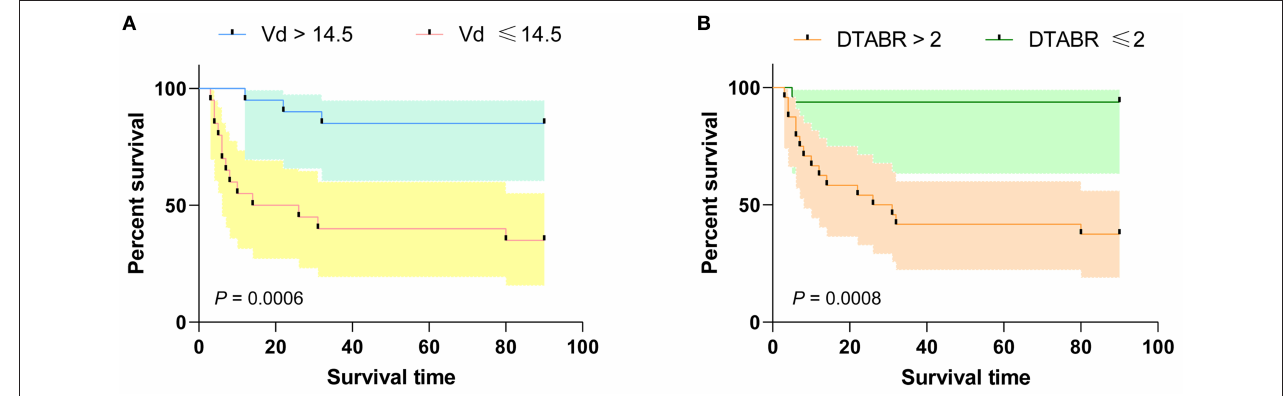
FIGURE 3 | Kaplan-Meier survival curves for the training cohort. (A) Kaplan-Meier survival curves for VD; (B) Kaplan-Meier survival curves for DTABR. Patients with a VD ≤ 14.5 had a higher risk of death than those with a VD > 14.5; the 90-day survival rate was lower in patients with a DTABR > 2 than in patients with a DTABR ≤ 2. VD, diastolic flow velocity; DTABR, (delta + theta)/(alpha + beta) ratio.